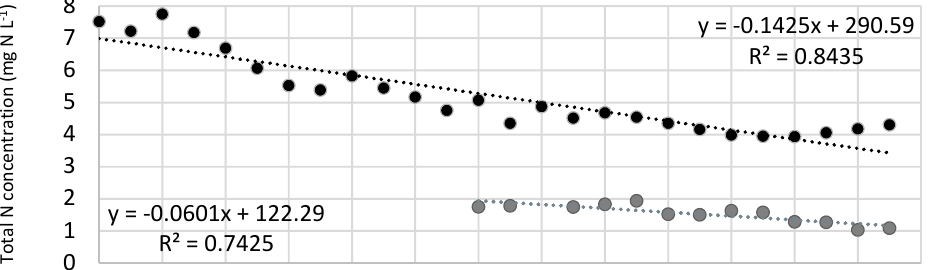
Figure 8. Historical concentrations of TN C based on data from the Valada Tejo (19E / 02) monitoring station in Portugal (2002–2015) and on Danish flow-weighted total N concentrations between (1990–2015) [18,19].